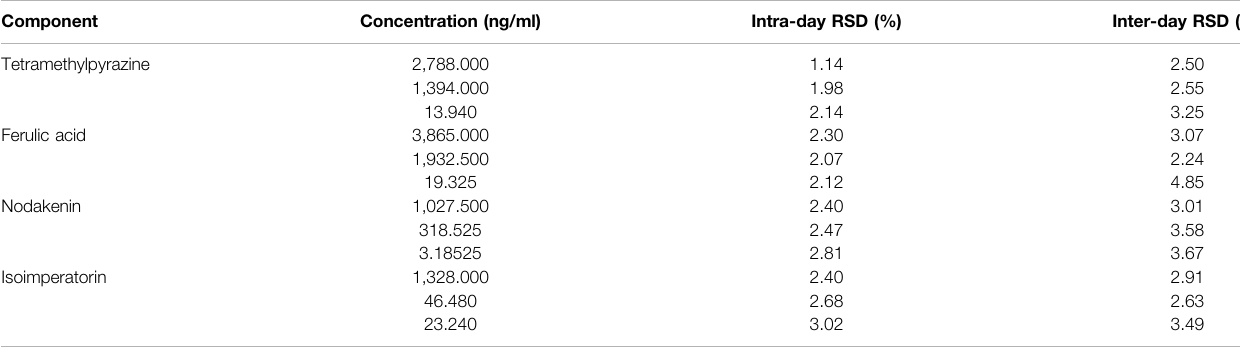
TABLE 7 | Intra-day and inter-day precision of tetramethylpyrazine, ferulic acid, nodakenin, and isoimperatorin in rabbit plasma ( n = 6). Component Tetramethylpyrazine